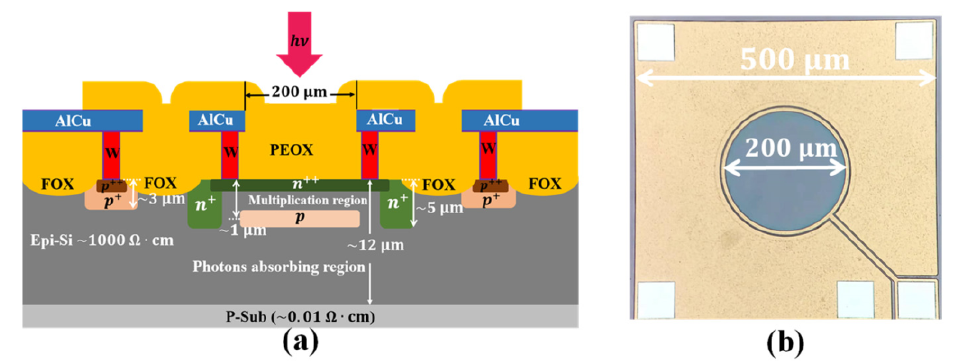
Figure 1. Structure of the silicon avalanche photodetector ( a ) cross-section schematic; ( b ) optical microscopy